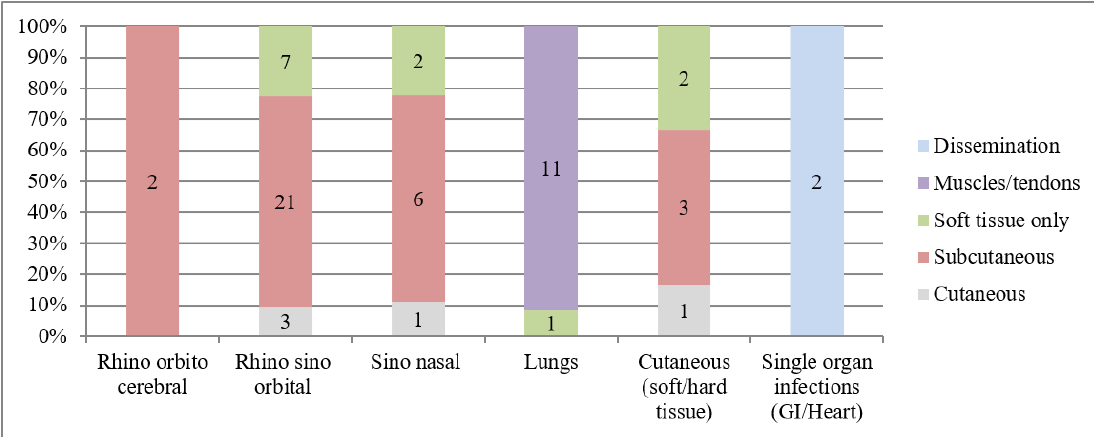
Figure 5. Site and tissue involvement in mucormycosis. Table 3. Multivariate analysis showing the interdependent variables as significant predictors of mortality in different IFI.